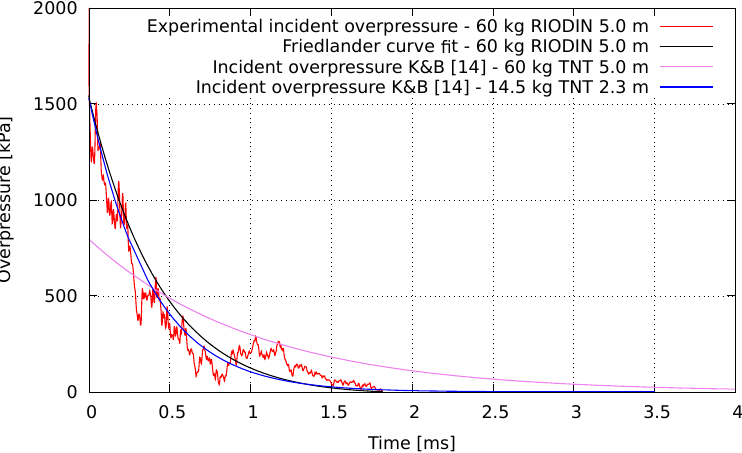
Figure 8. Plots of incident pressures for 60 kg of RIODIN at 5 m (test #1 ground sensor). Although specific reflected pressure gauges were not available, in serial test #2, an attempt was made to measure the reflected pressures using general purpose gauges, by placing two pressure sensors facing the blast and attached at midspan of the panels. However, during the test, one of the sensors was broken and the other recorded the pressure with significant noise due to spurious reflections. Therefore, these results were not considered